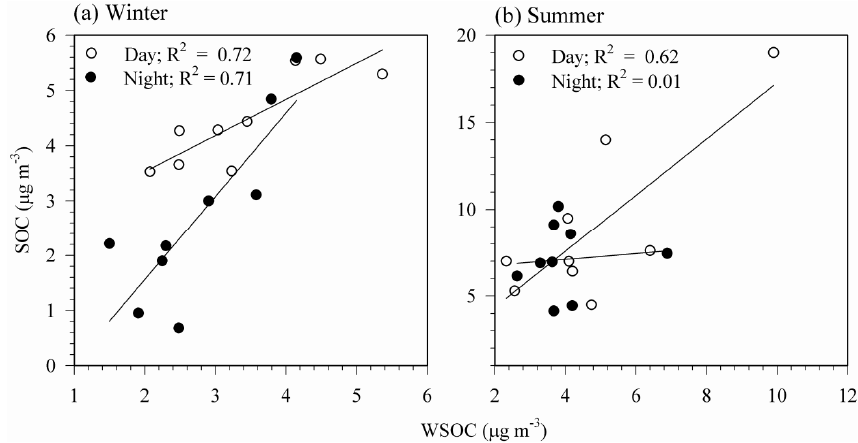
Fig. 5. Scatter plots between water-soluble organic carbon (WSOC) and secondary organic carbon (SOC) during (a) winter and (b) summer seasons showing a linear